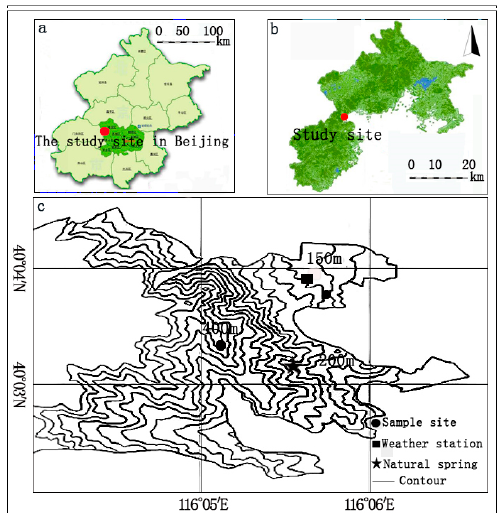
Figure 1. Map of the study region: ( a ) Location of National Forest Ecosystem Research Station (NFERS) in Beijing, China. ( b ) Location of the study region within the NFERS. ( c ) Location of the sampling sites within the study region.